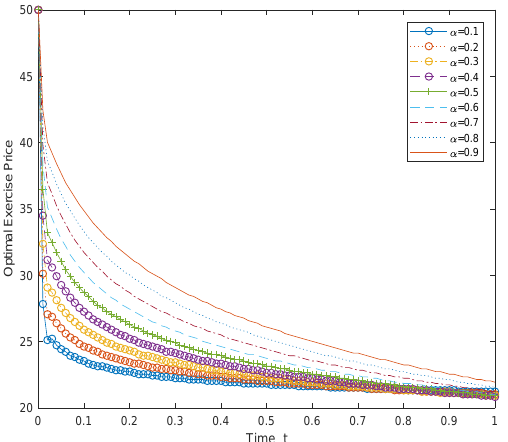
Figure 5. Optimal exercise prices for American put options with different α